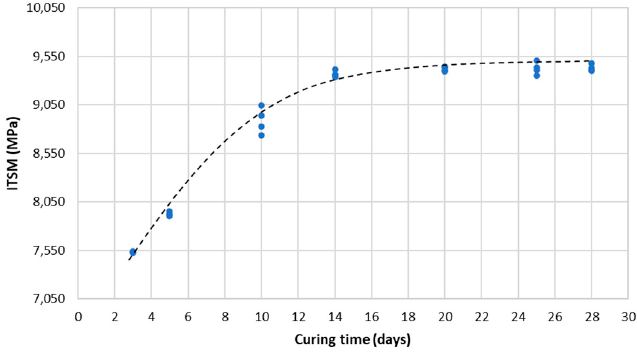
Figure 18. ITSM of CRAJ mixture at 25 °C vs. curing time.